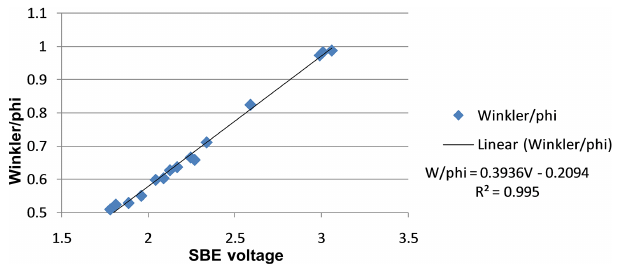
Figure 2. Linear regression line calculated for the DO data of a CTD